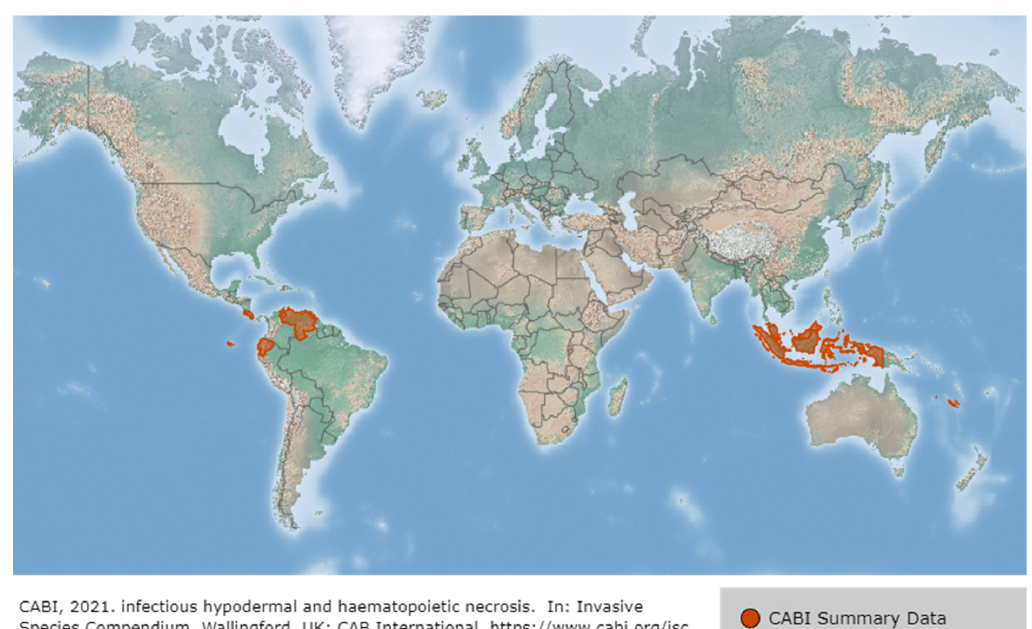
Figure 8. Distribution maps showing the geographical occurrence of infectious hypodermal and hematopoietic necrosis virus (Reprinted from CABI, 2019, Infectious hypodermal and hematopoietic necrosis. In: Invasive Species Compendium. Wallingford, UK: CAB International, with permission from CABI).